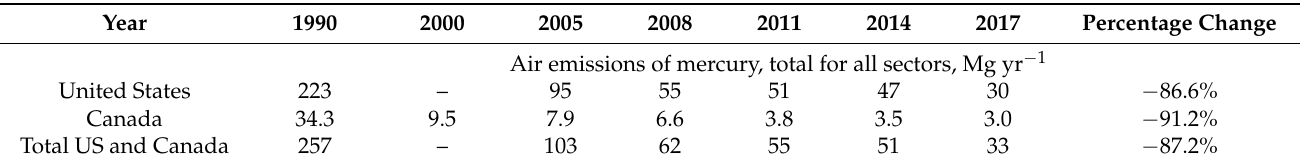
Table 1. Trends in emissions of mercury in the U.S. [9] and in the Canadian provinces of Manitoba and Ontario [10], 1990–2017. [U.S. data were reported in short tons; Canadian data were reported in kilograms [kg]; all data have been converted to Mg yr − 1 ; percentage change is from 1990 to